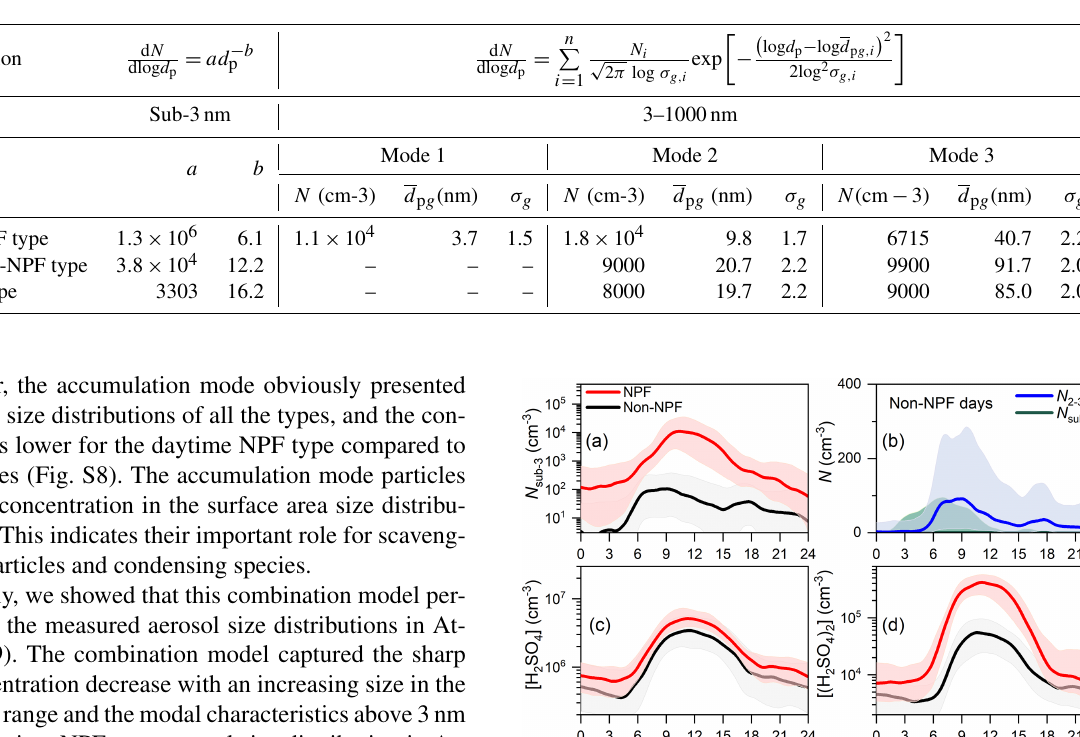
Table 1. The fitting parameters for the median daytime NPF, daytime non-NPF, and nighttime type aerosol size distributions of 4-year measurements in urban Beijing by the combination of the power law function and the lognormal distribution function. The power law function includes two parameters, a and b . The lognormal distribution function includes the number concentration within the mode ( N ), the geometric mean diameter within the mode ( d p g ), and the standard deviation ( σ g )